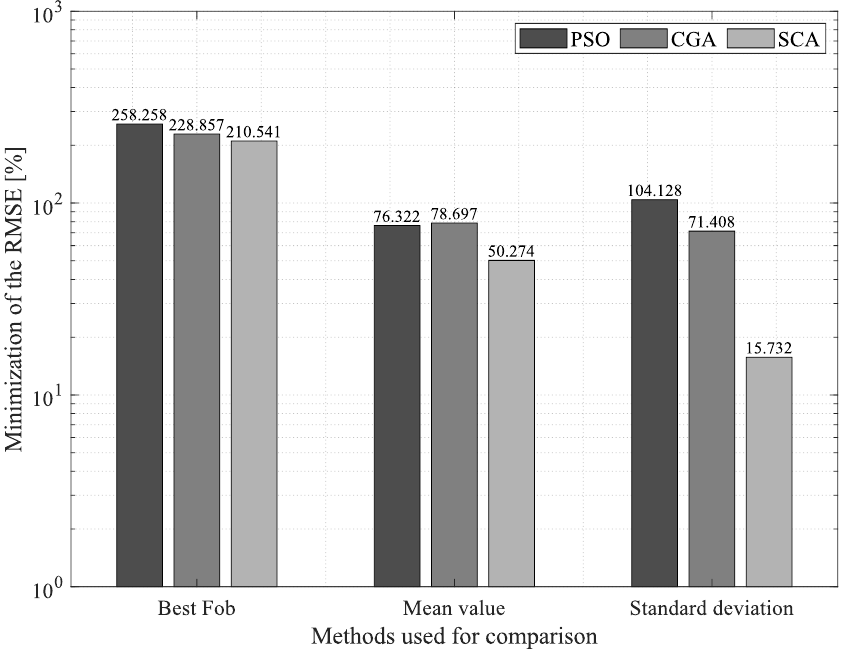
Figure 6. Minimization of the RMSE in the TDM of a MSX 60 PV panel under a 500 W/m 2 irradiance level obtained by the SSA compared to the other